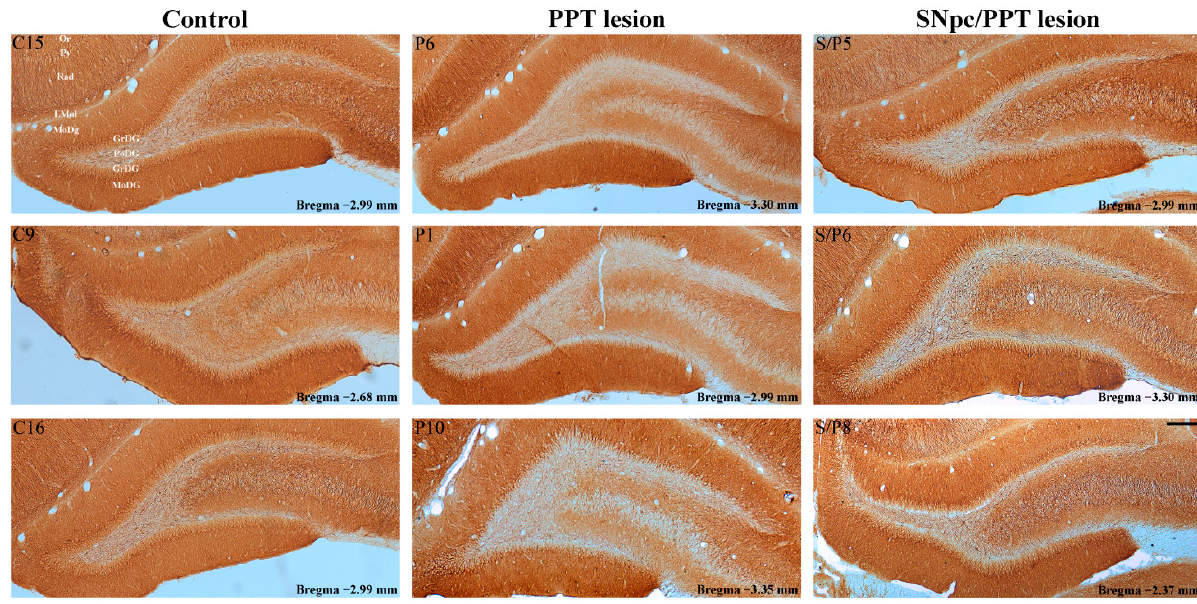
Figure 7. Alteration of MAP2 immunostaining within DG in the distinct rat models of PD neuropathology. MAP2 immunoreactivity within DG of the control rats (Control, C15, C9, C16), the rats with PD cholinopathy (PPT lesion, P6, P1, P10) and the hemiparkinsonian rats with PD cholinopathy (SNpc/PPT lesion, S/P5, S/P6, S/P8). Or—oriens layer of the hippocampus; Py—pyramidal cell layer of the hippocampus; Rad—radiatum layer of the hippocampus; LMol—lacunosum molecular layer of the hippocampus; MoDG—molecular layer of the dentate gyrus; GrDG—granule cell layer of the dentate gyrus; PoDG—polymorph cell layer of the dentate gyrus. Scale bar is 200 μ m. MAP2 immunoreactivity was suppressed in the rats with PD cholinopathy, but it was enhanced in the hemiparkinsonian rats with PD cholinopathy within DG granular and polymorphic cell layers vs. the control